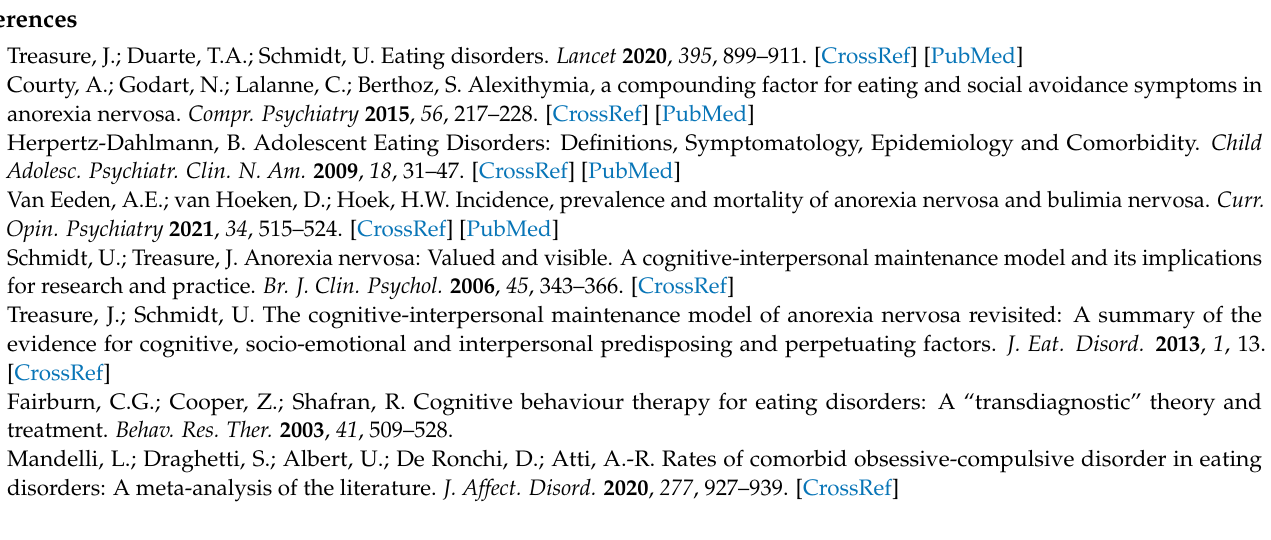
weights, Figure S5. Results of edge difference test, Figure S6. Bootstrapped difference test for strength, Figure S7. Bootstrapped difference test for bridge strength and R